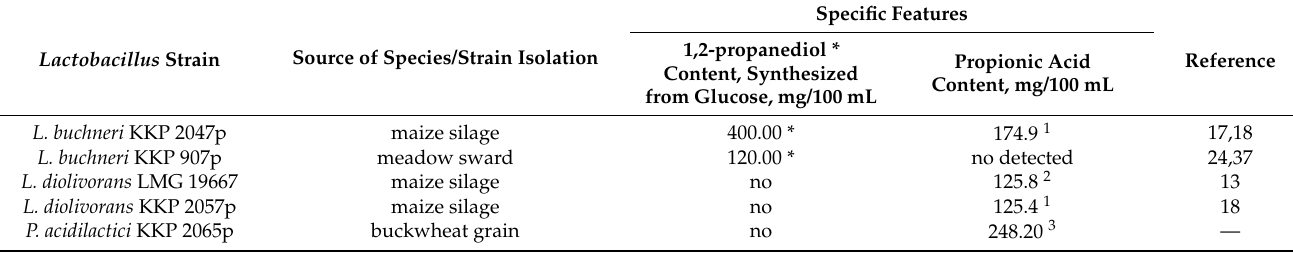
Table 1. Ability of strains species L. buchneri. L. diolivorans and P. acidilactici to synthesize and/or metabolize 1,2-propanediol.